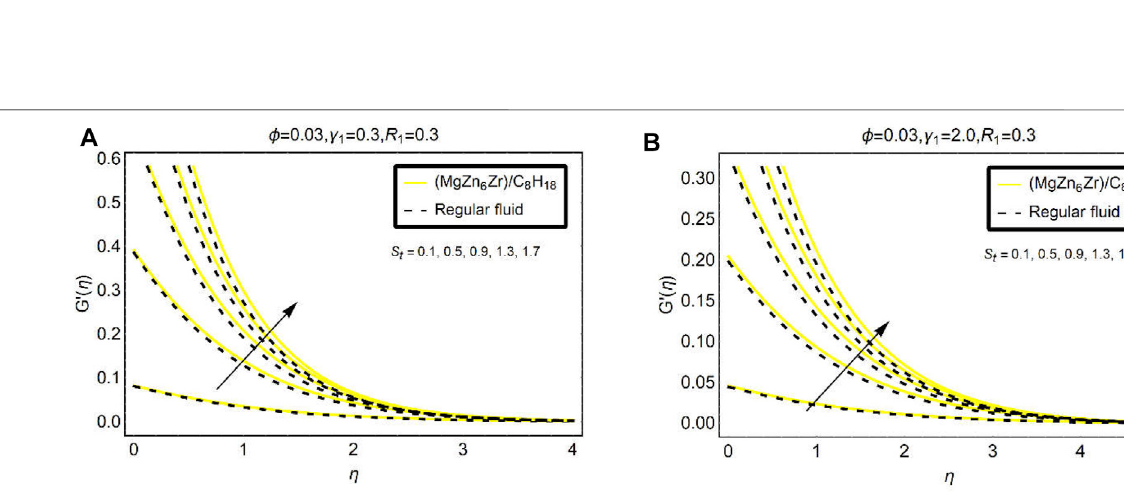
FIGURE 7 | Velocity G ’ via S t (A) γ 1 (cid:2) 0 . 3 and (B) γ 1 (cid:2) 2 . 0.